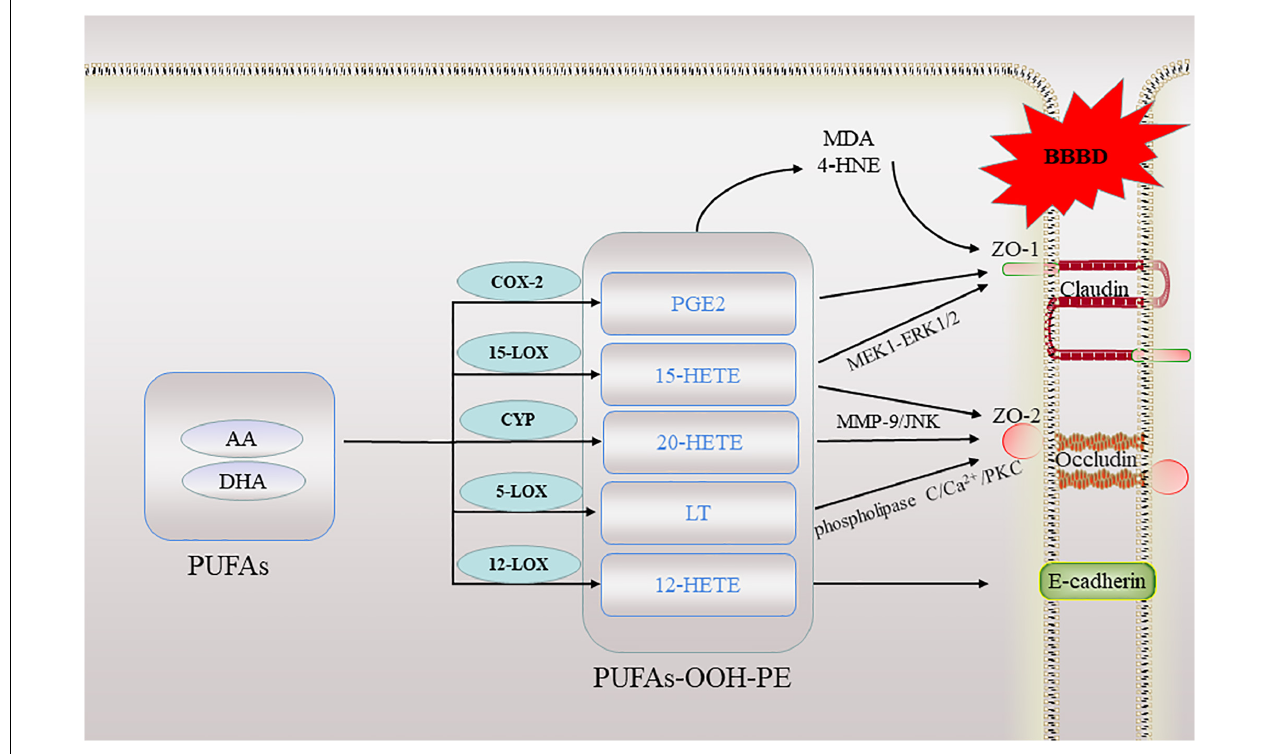
FIGURE 3 | A schematic of lipid peroxidation occurring in the blood brain barrier. When ferroptosis occurs, lipid peroxidation directly or indirectly involved in this process destroy the tight junctions between cells in the blood-brain barrier. BBBD, blood-brain barrier dysfunction; AA, arachidonic acid; DHA, docosahexaenoic acid; ZO, zonula occludens; 20-HETE, 20-hydroxyeicosatetraenoic acid; 15-HETE, 15-hydroxyeicosatetraenoic acid; 12-HETE, 12-hydroxyeicosatetraenoic acid; LT, Leukotrienes; PGE2, prostaglandin E2; PKC, protein kinase C; MMP, matrix metalloproteinases; MDA, malondialdehyde; 4-HNE,